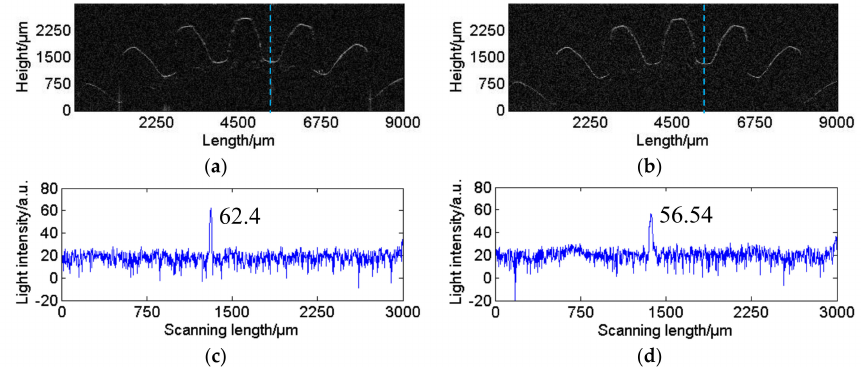
Figure 8. OCT images of two gears with different roughnesses: ( a ) low level of roughness; ( b ) high level of roughness; ( c ) and ( d ) are the corresponding FFT results of the spectrogram at the dashed line in ( a ) and ( b